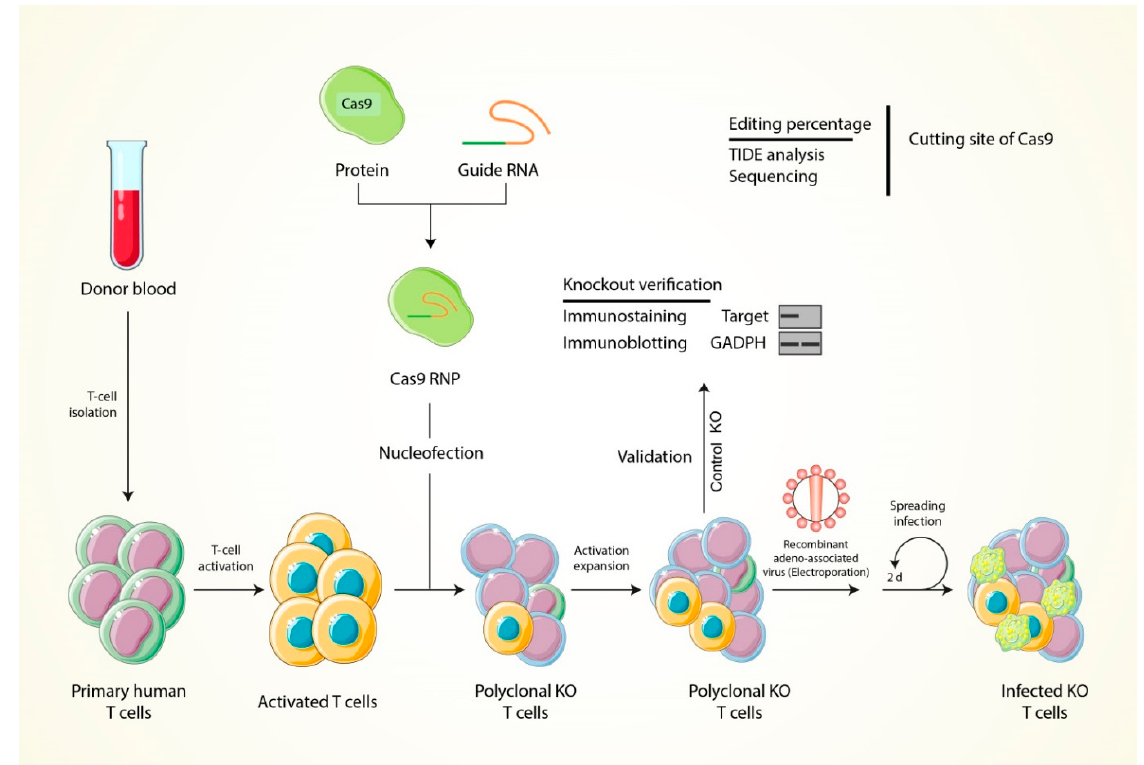
Figure 6. The estimated strategy of T cell modification through using the CRISPR-Cas9 genome editing tool. Here, the donor blood cells have to be extracted to collect primary human T cells, then these cells are transformed into polyphenols KO T cells by our mostly desired CRISPR-Cas9 genome editing tool. After that, these genetically modified polyclonal T cells are validated by knockout verification and finally injected into the cancer patient body.